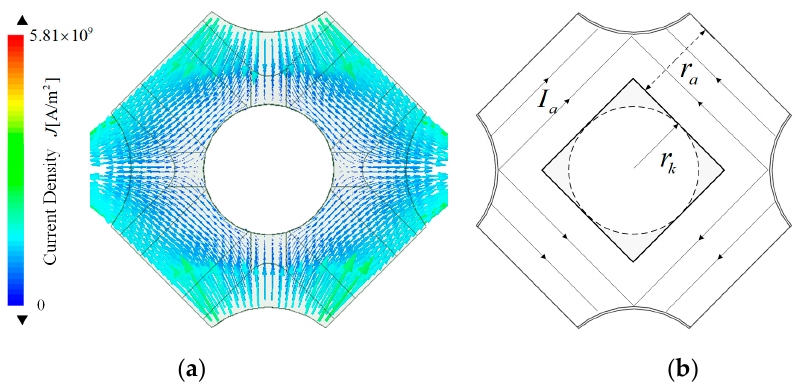
Figure 8. Simplified process of armature current. ( a ) Current distribution; ( b ) simplified current